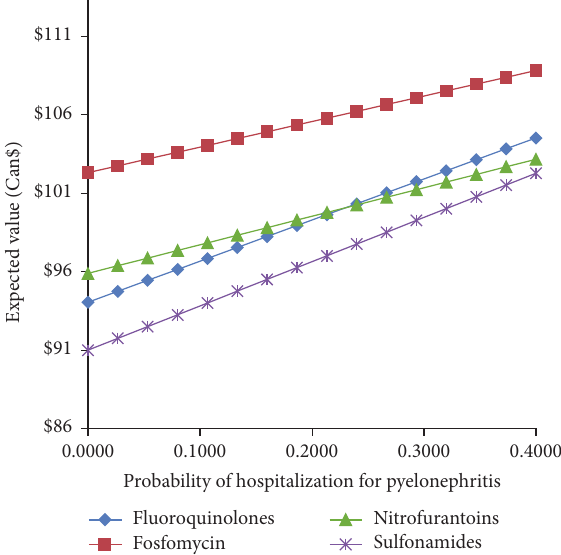
Figure 7: Comparison of the expected value of the cost-per-patient when treating uUTI with fluoroquinolones, sulfonamides, nitrofu- rantoin, and fosfomycin versus the probability of hospitalization for pyelonephritis.